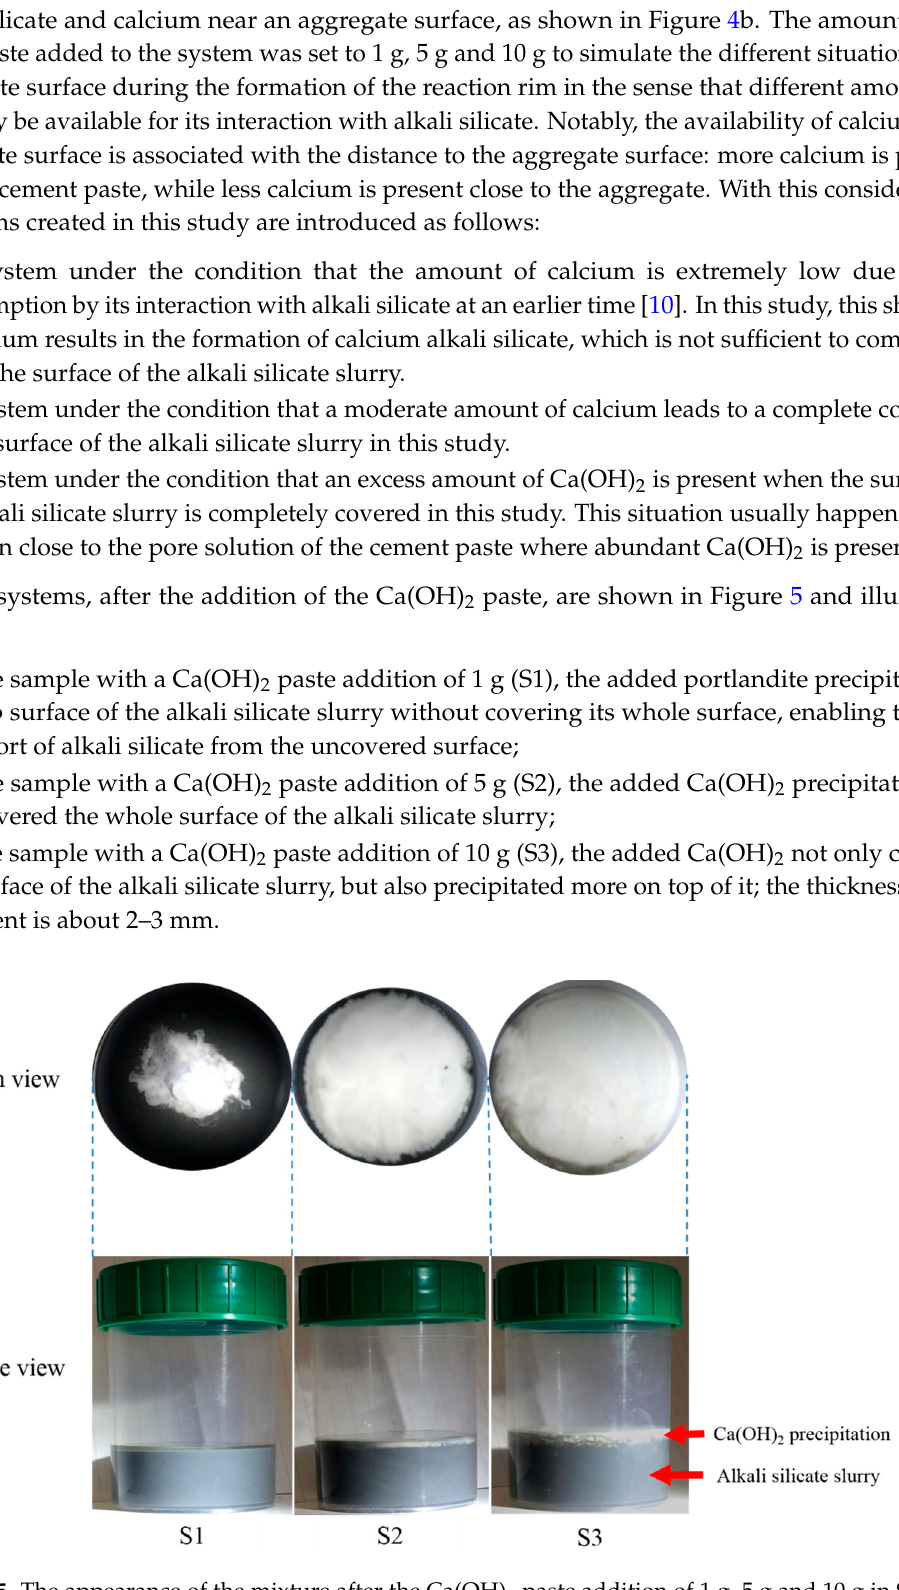
Figure 5. The appearance of the mixture after the Ca(OH) 2 paste addition of 1 g, 5 g and 10 g in S1, S2 and S3, respectively.